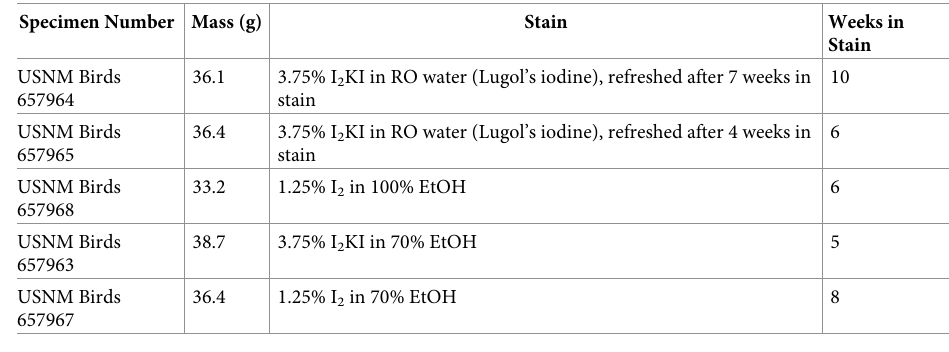
The specimen number, specimen mass immediately before staining, concentration and formula of the stains used on each specimen, and the duration of staining for each specimen. Specimens were scanned prior to staining and weekly during the staining process to assess